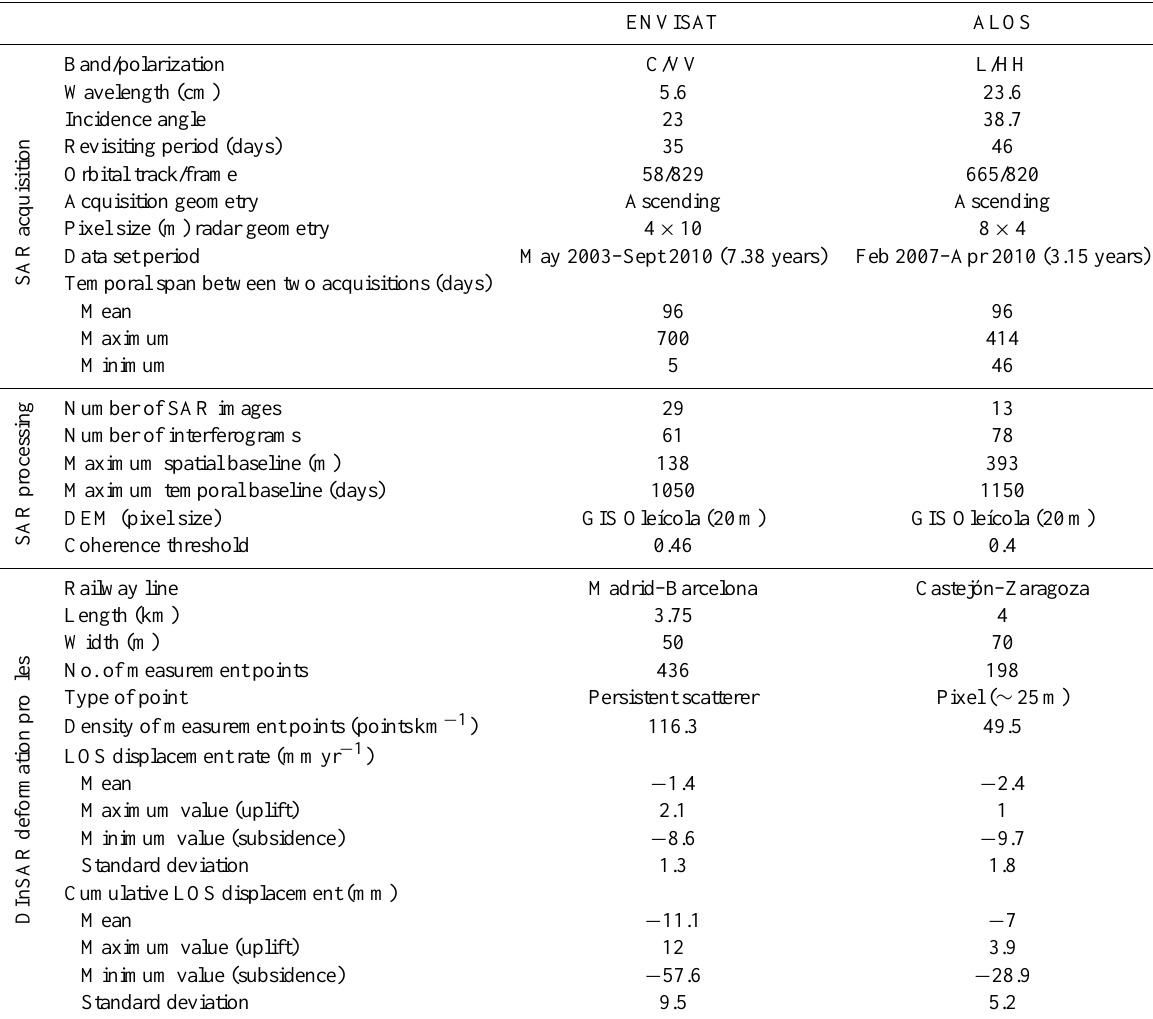
Table 1. Main characteristics of the SAR data sets and DInSAR deformation